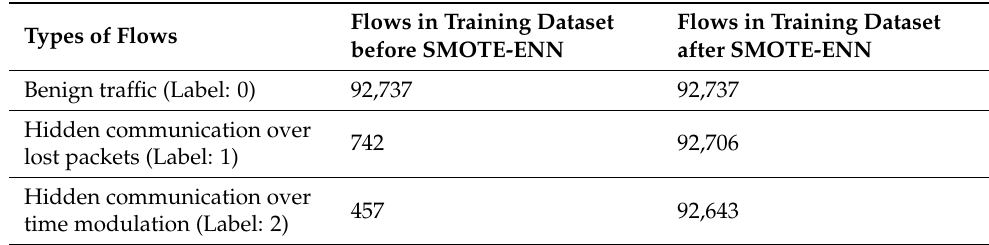
Table 5. Data augmentation results—number of flows in training dataset before and after SMOTE- ENN.